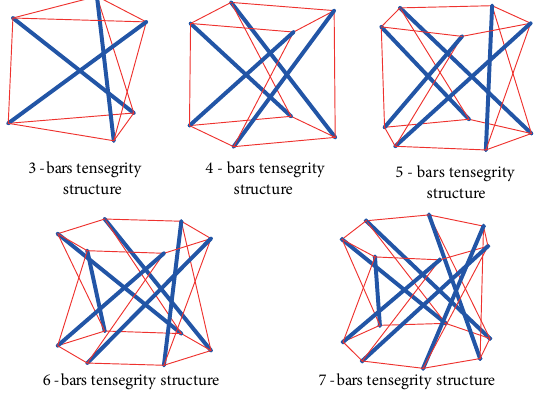
Figure 1. Common single-layer tensegrity